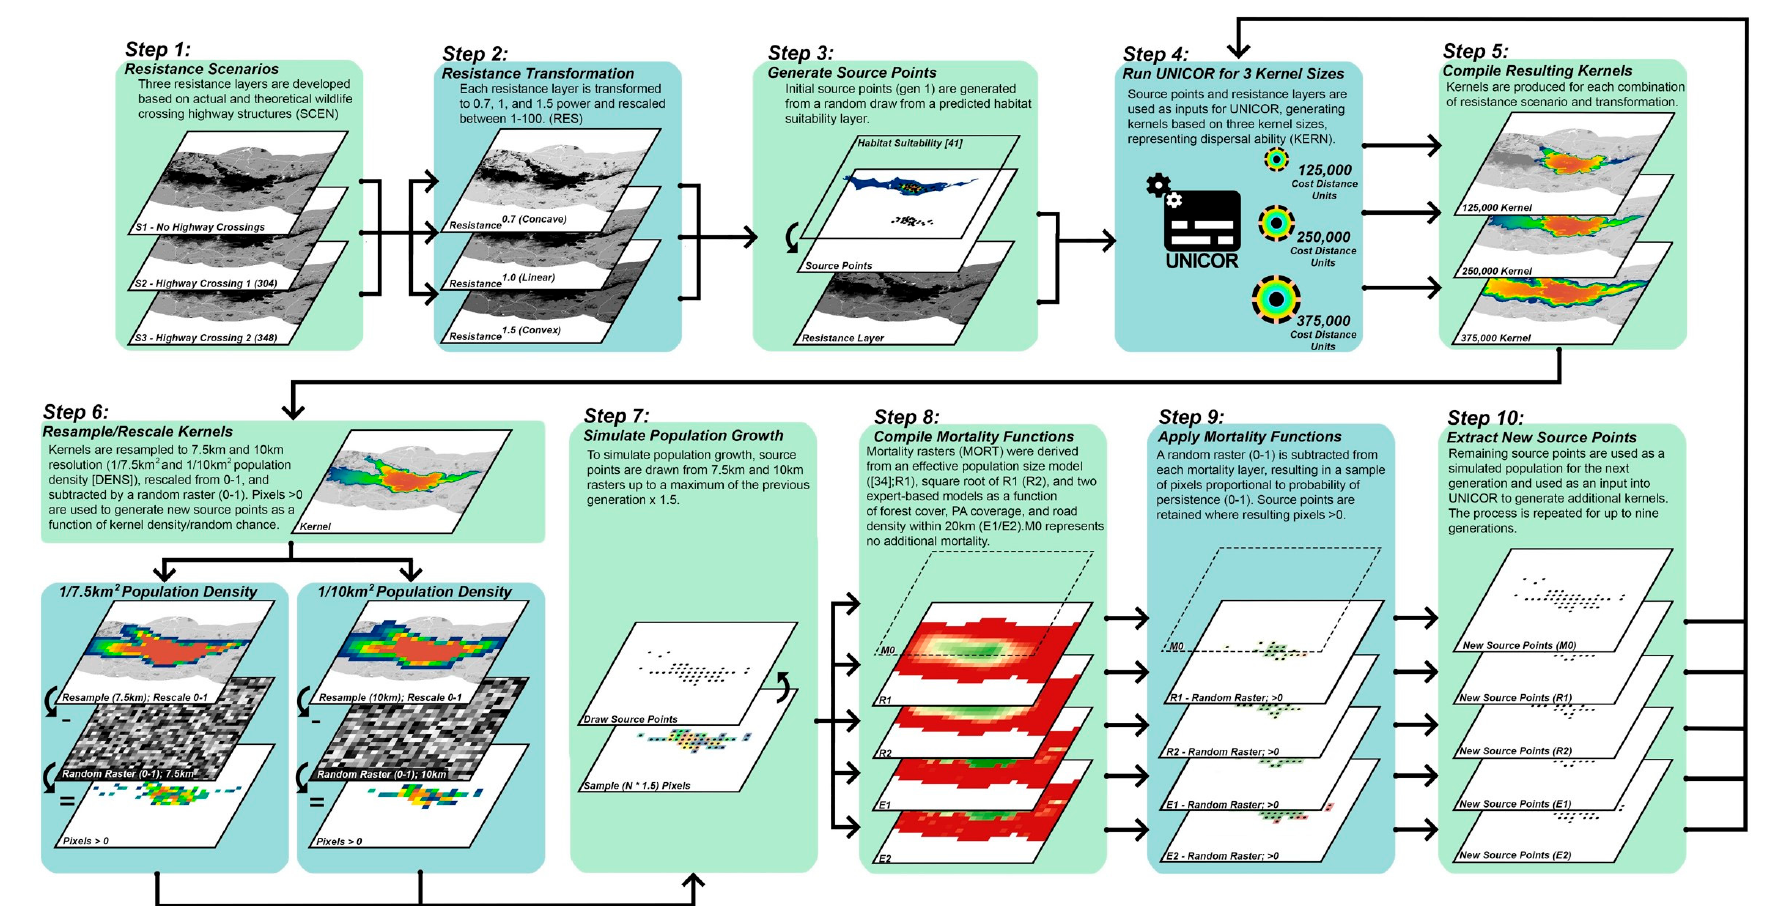
Figure 2. Diagram depicting methods workflow, including development of highway crossing resistance scenarios (SCEN), resistance transformation (RES), adjusting dispersal ability (KERN), adjusting population density (DENS), and developing and applying mortality functions (MORT). Ash et al. [41]; Reddy et al. [34].